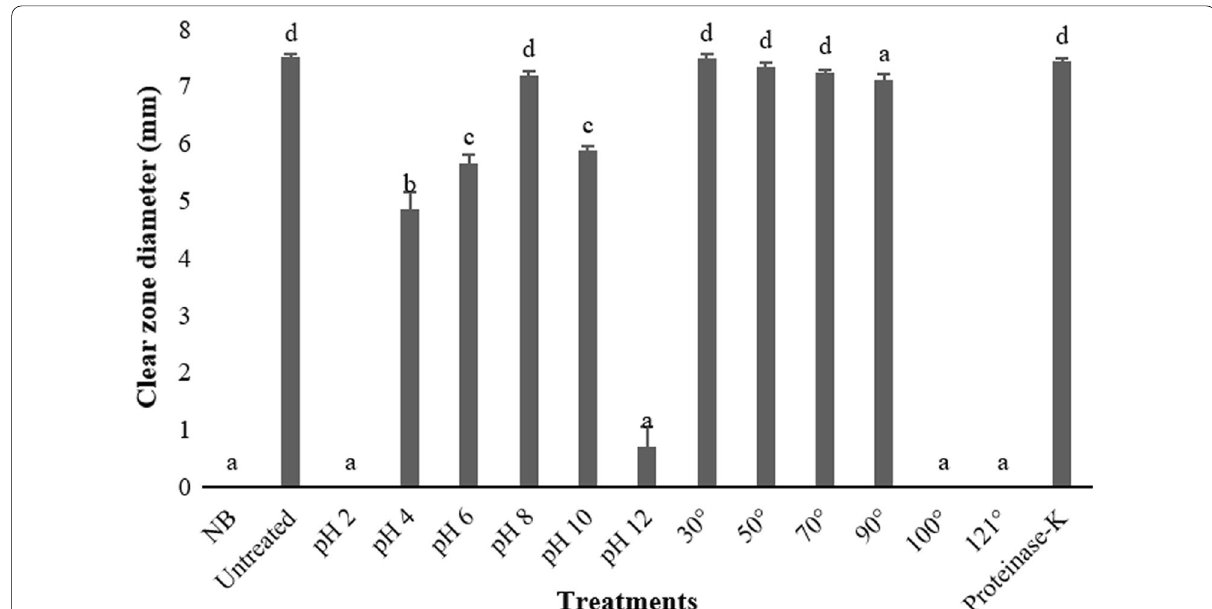
Fig. 6 Inhibitory activities of the untreated and treated cell-free supernatant (CFS) of bacterial isolate C8 against XCC. Different letters on each histogram indicated any difference in clear zone diameter among bacteria isolates and culture age ( p <